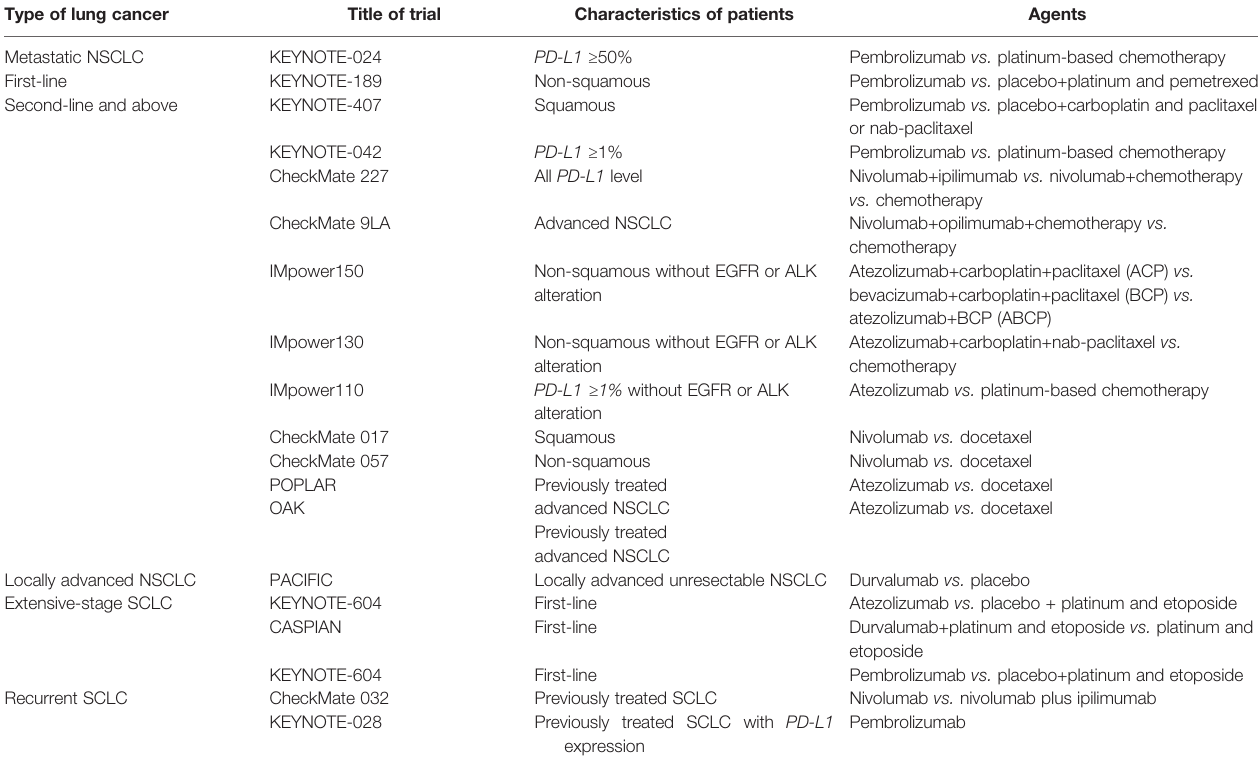
TABLE 1 | Major Clinical Trials Demonstrating the Ef fi cacy of ICI Immunotherapy for Lung Cancer. Type of lung